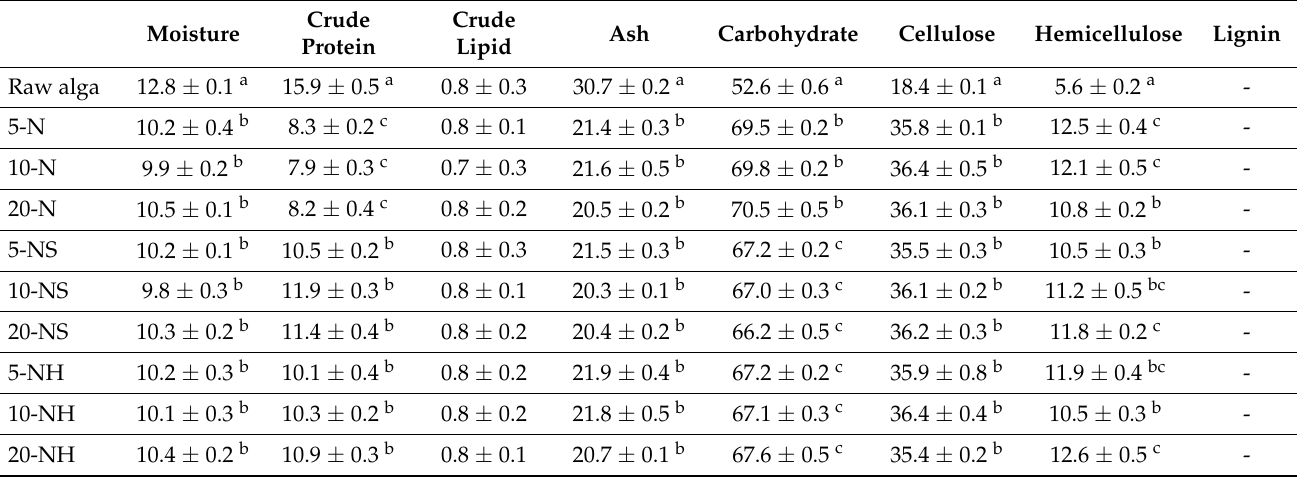
Table 2. Moisture and proximate composition (% dry weight) of raw Rhizoclonium and Rhizoclonium pulp samples after